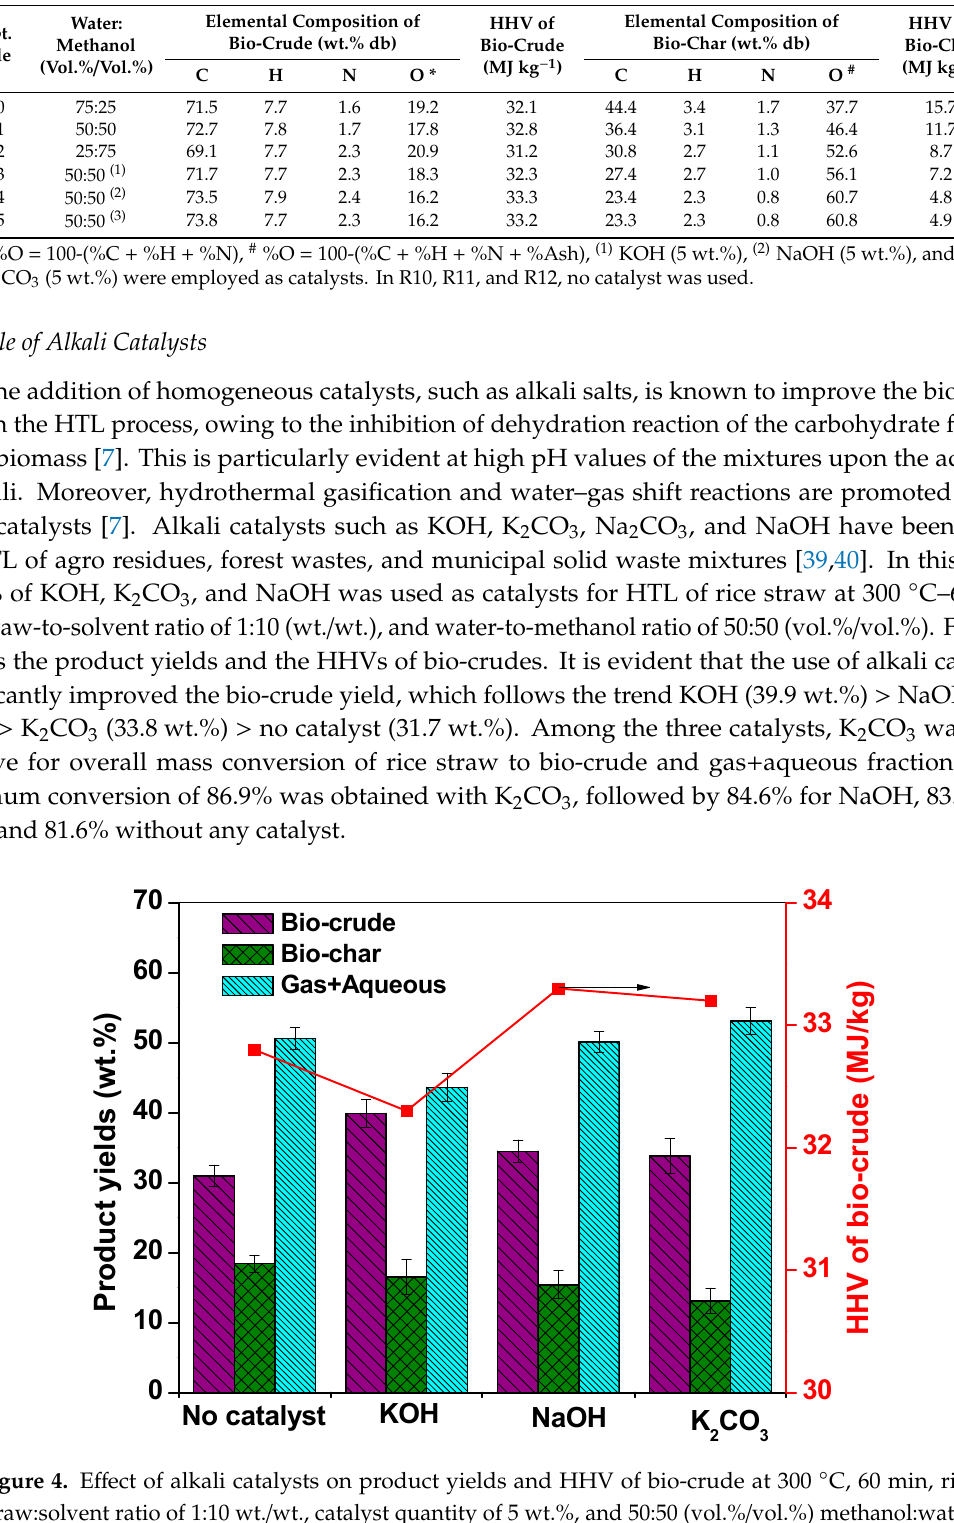
Table 4. E ff ect of water-to-methanol ratio and catalysts on elemental composition of bio-crude and bio-char, and HHVs of bio-crude and bio-char at final process temperature of 300 ◦ C, reaction time of 60 min, and rice-straw-to-solvent ratio of 1:10 wt. / wt.